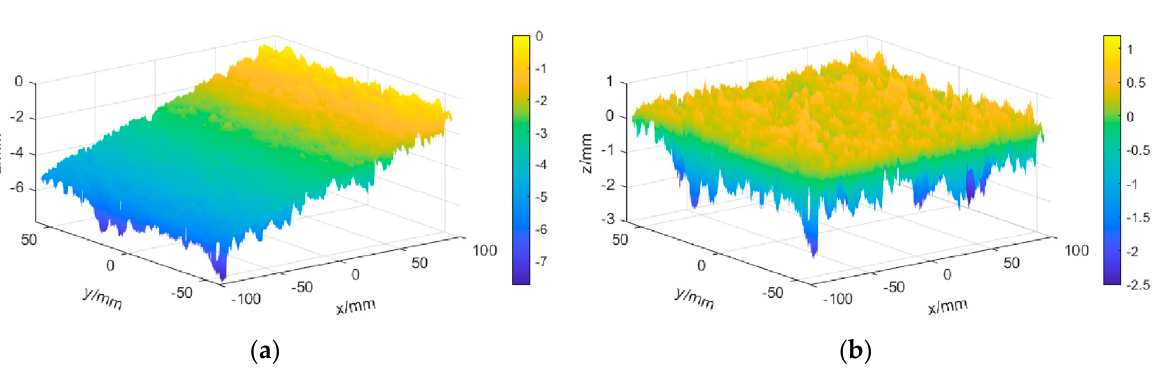
Figure 2. SC of pavement texture. ( a ) Pavement texture before SC. ( b ) Pavement texture after SC.